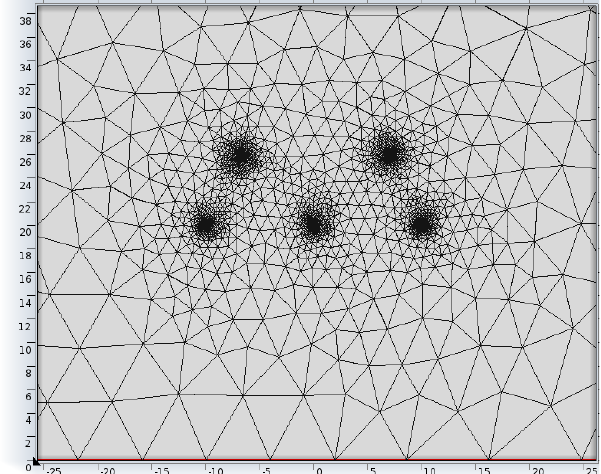
Figure 19: Finite element discretization of the study domain given in Figure 3.